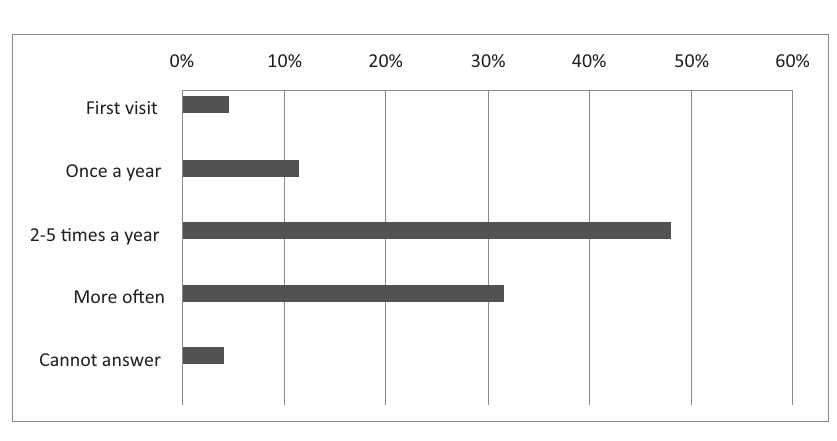
Fig. 7. Frequency of festival visits in Vilnius